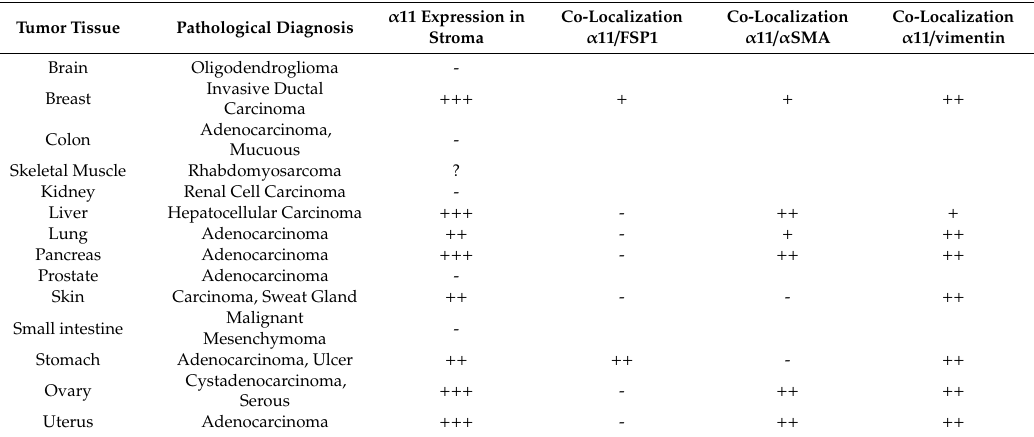
Table 2. Summary of integrin α 11 expression and its co-localization with other stroma markers in tumor sections of the tissue